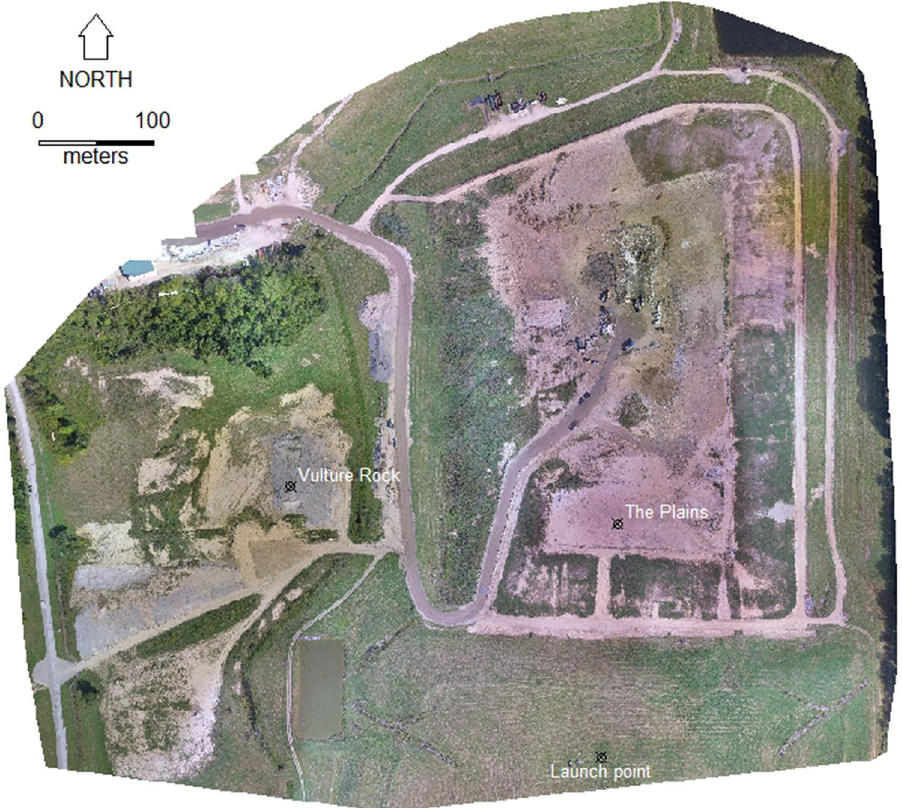
Figure 1. Study locations at the Erie County Landfill, Milan, Ohio. Base map was created using geo-referenced images from the DJI Inspire and Drone2Map (version 1.3.2.232, ESRI, Redlands, California, USA). Map was created by